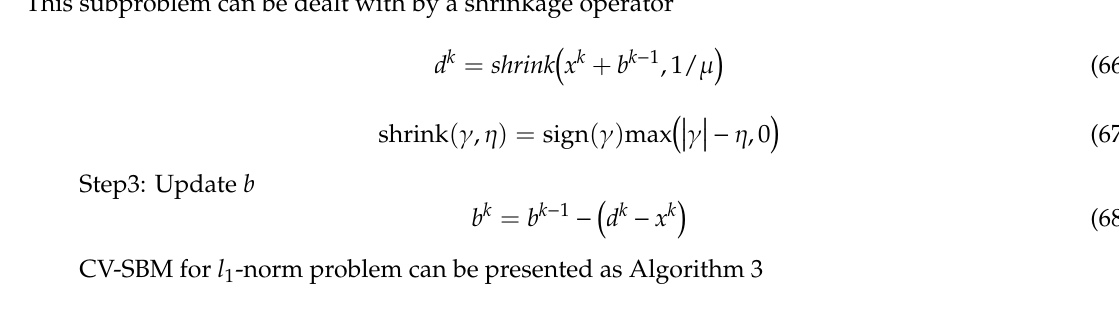
Algorithm 3: CV-SBM for l1-norm